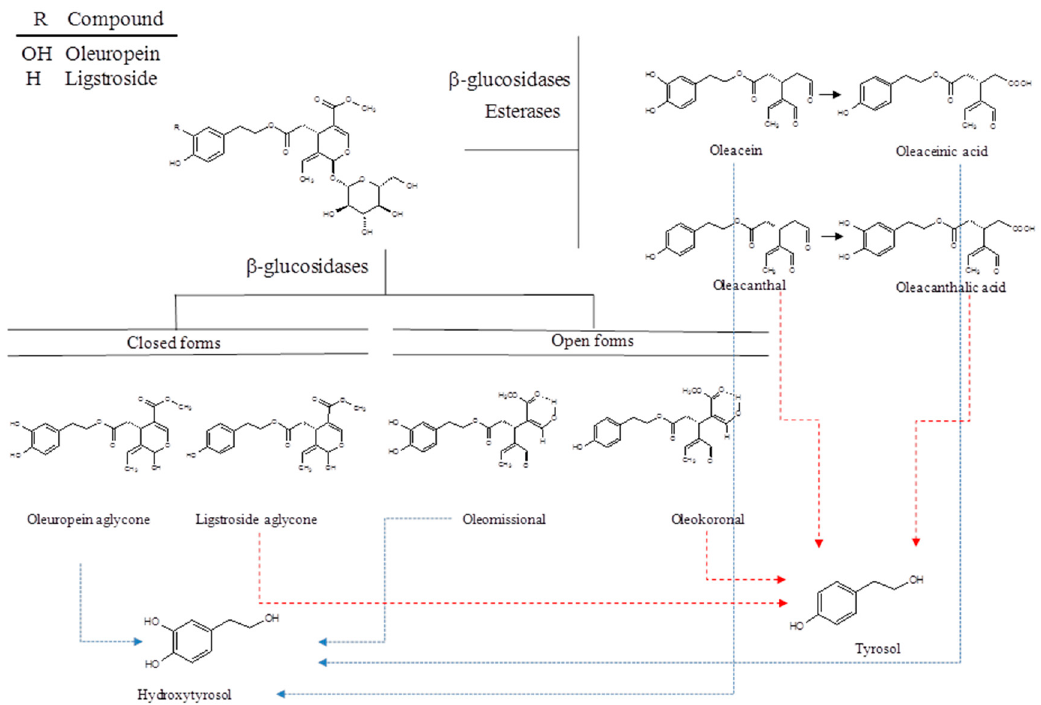
Figure 1. Chemical structures of phenolic alcohols and secoiridoids compounds in EVOO.